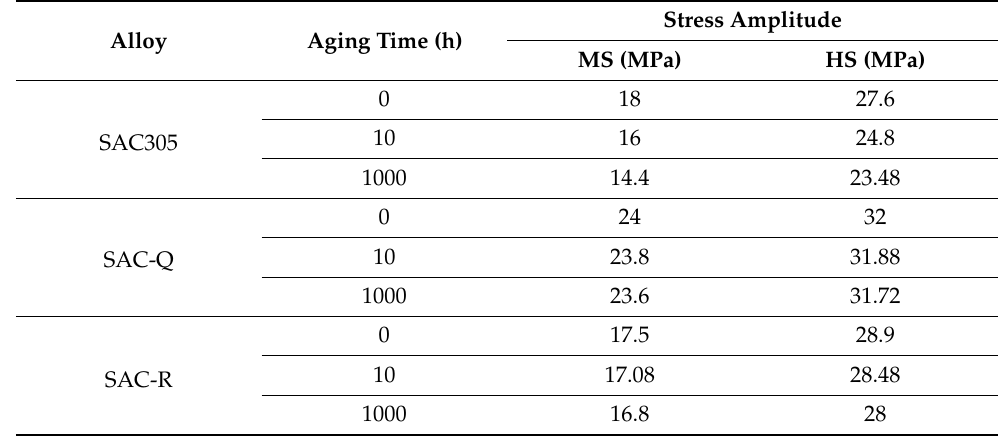
Table 2. Stress amplitude for solder alloys aged for 0, 10, 1000 h.